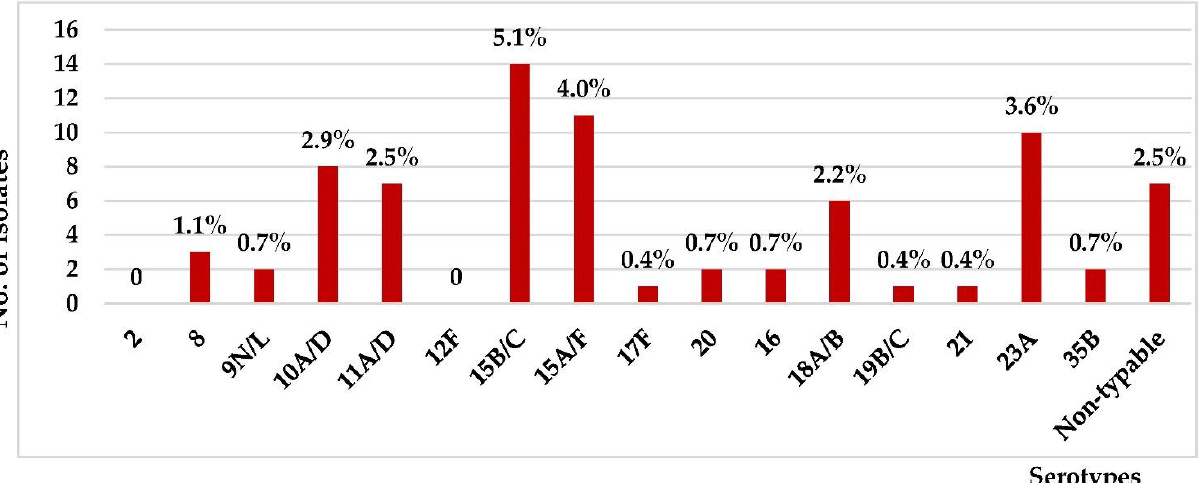
Figure 3. Antimicrobial susceptibilities of pneumococcus-causing IPD in central Thailand, 2012 – 2016. Serotype 19A was associated with lower susceptibility than the non-19A isolates to penicillin (75.0% vs. 87.5%, p = 0.045), meropenem (52.8% vs. 90.8%, p < 0.001), erythromy- cin (33.3% vs. 53.8, p =0.022), and TMP-SMZ (16.7% vs. 45.0%, p =0.001), Figure 4. PCV10 covered 29.7%, 33.3%, 28.2%, and 57.0% of the isolates that were non-susceptible to peni- cillin, cefotaxime, meropenem, and erythromycin, respectively. PCV13 provided higher